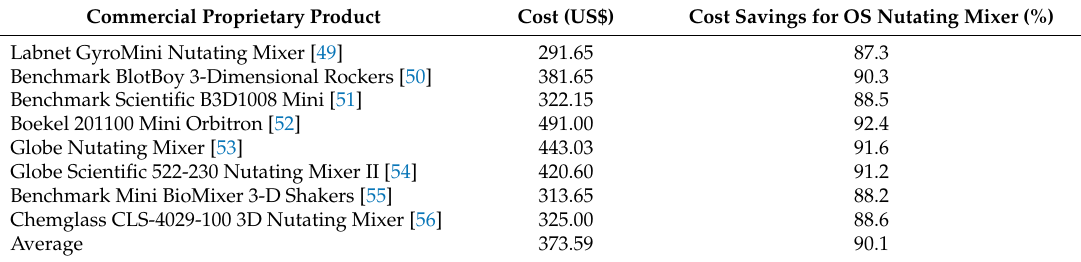
Table 3. Commercial nutating mixers cost and cost saving percent for the use of the open source nutating